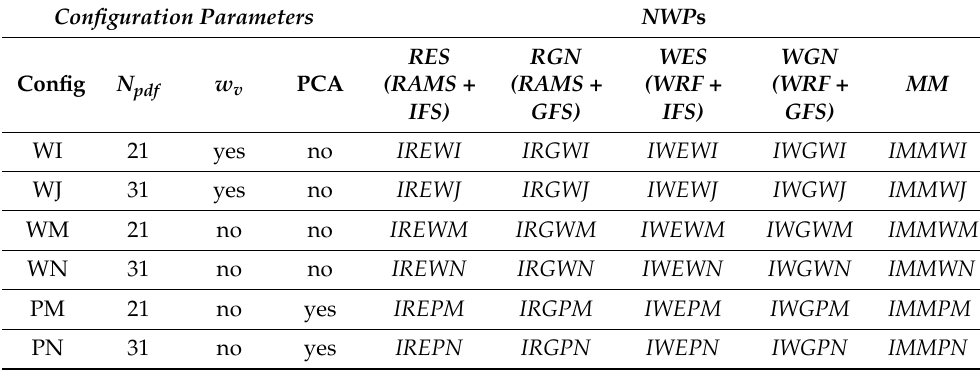
Table 3. List of the AnEn configurations. Configuration